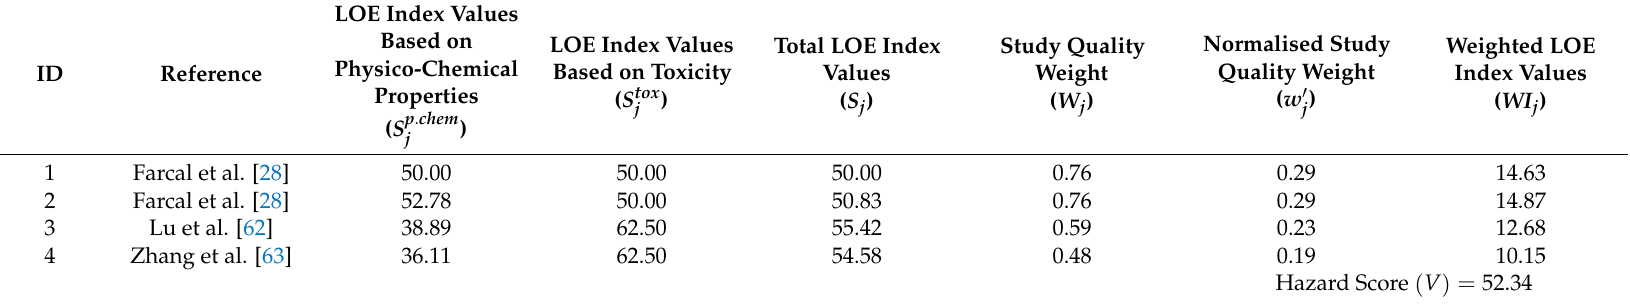
Table A2. Quantitative WoE results for nano-ZnO. Each LOE represents experimental evidence from academic literature evaluated based on physico-chemical properties, toxicity, and study quality. The overall hazard of nano-ZnO ( V ) is derived from sum of all LOE-specific hazard scores ( WI j